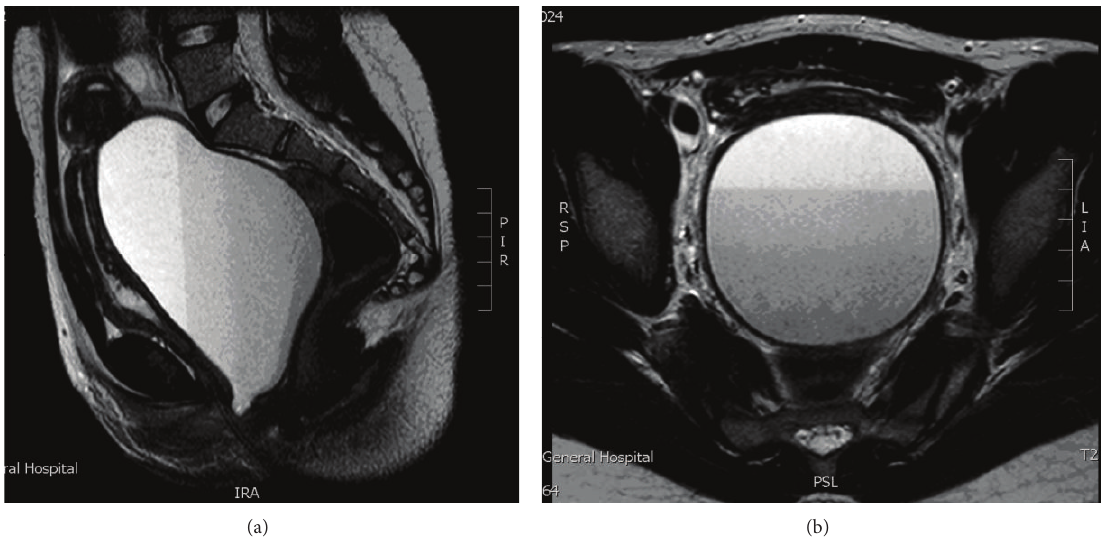
Figure 2: MRI scans showing the differential layers of fluid indicative of blood